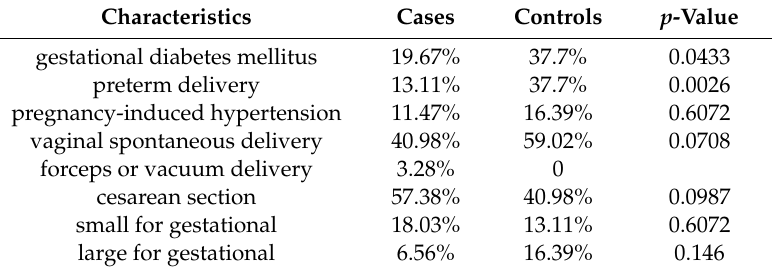
Table 4. Influence of bariatric surgery on